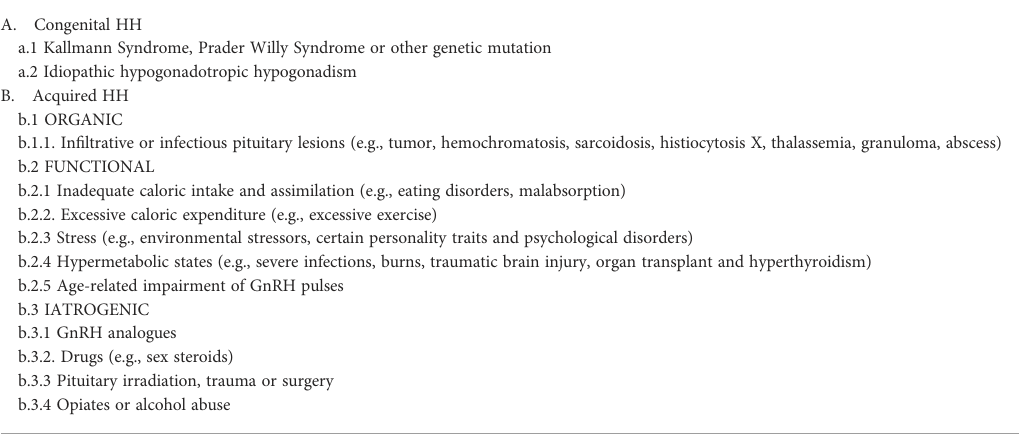
TABLE 1 Causes of hypogonadotropic hypogonadism in